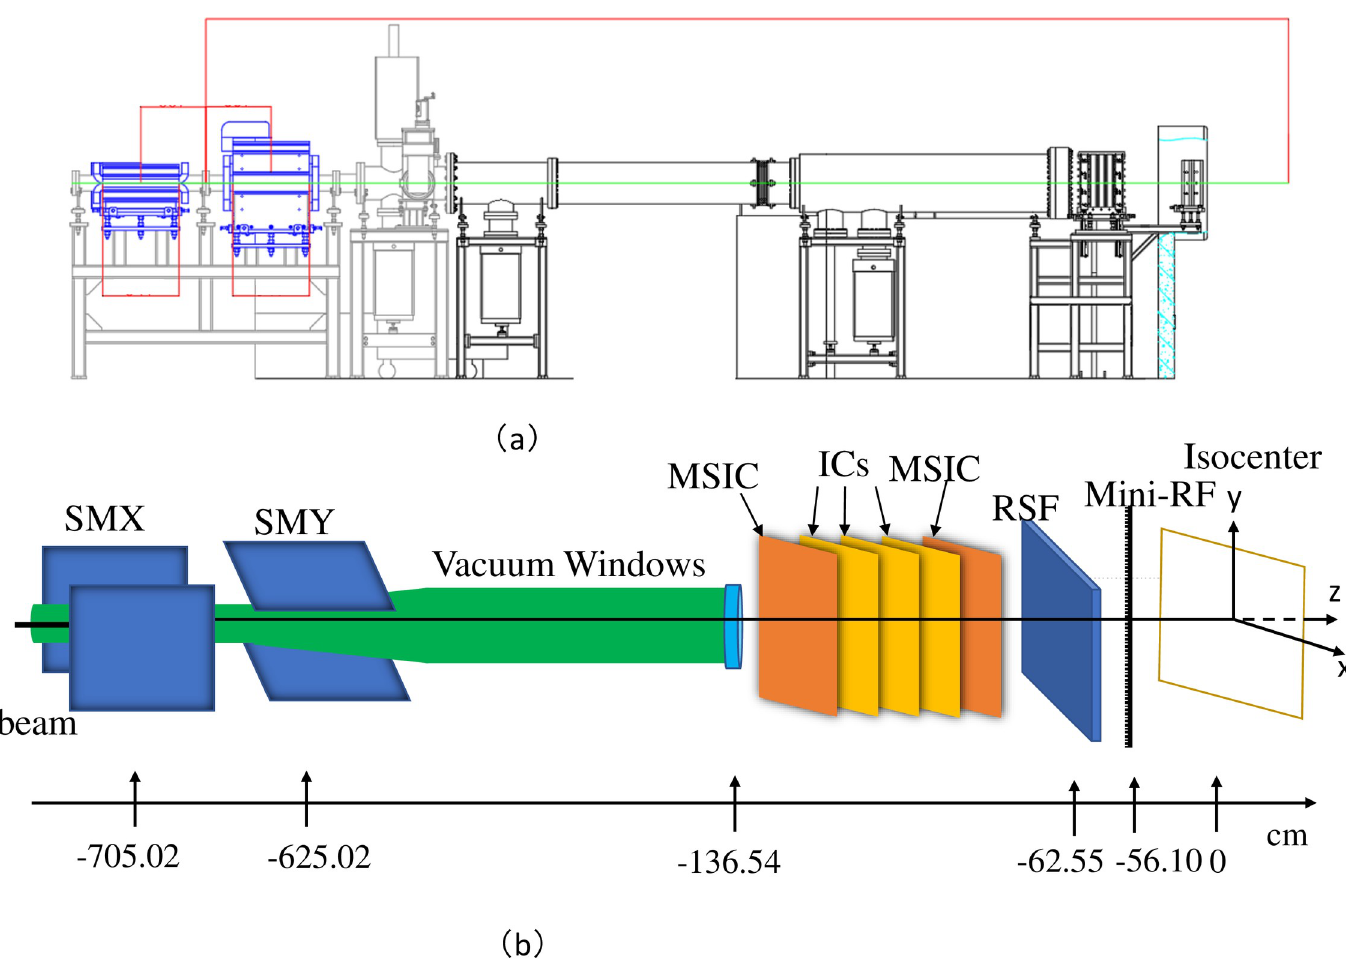
Fig 1. Fixed horizontal beamline for modulated spot scanning delivery. (a) Layout of the HIMM; (b) The PB scanning treatment head implemented in the MC code, showing the incident beam direction, scanning magnets (SMX, SMY), ionization chambers (IC); mini-RF, ripple filter; RS, range shifter. Unit: cm.